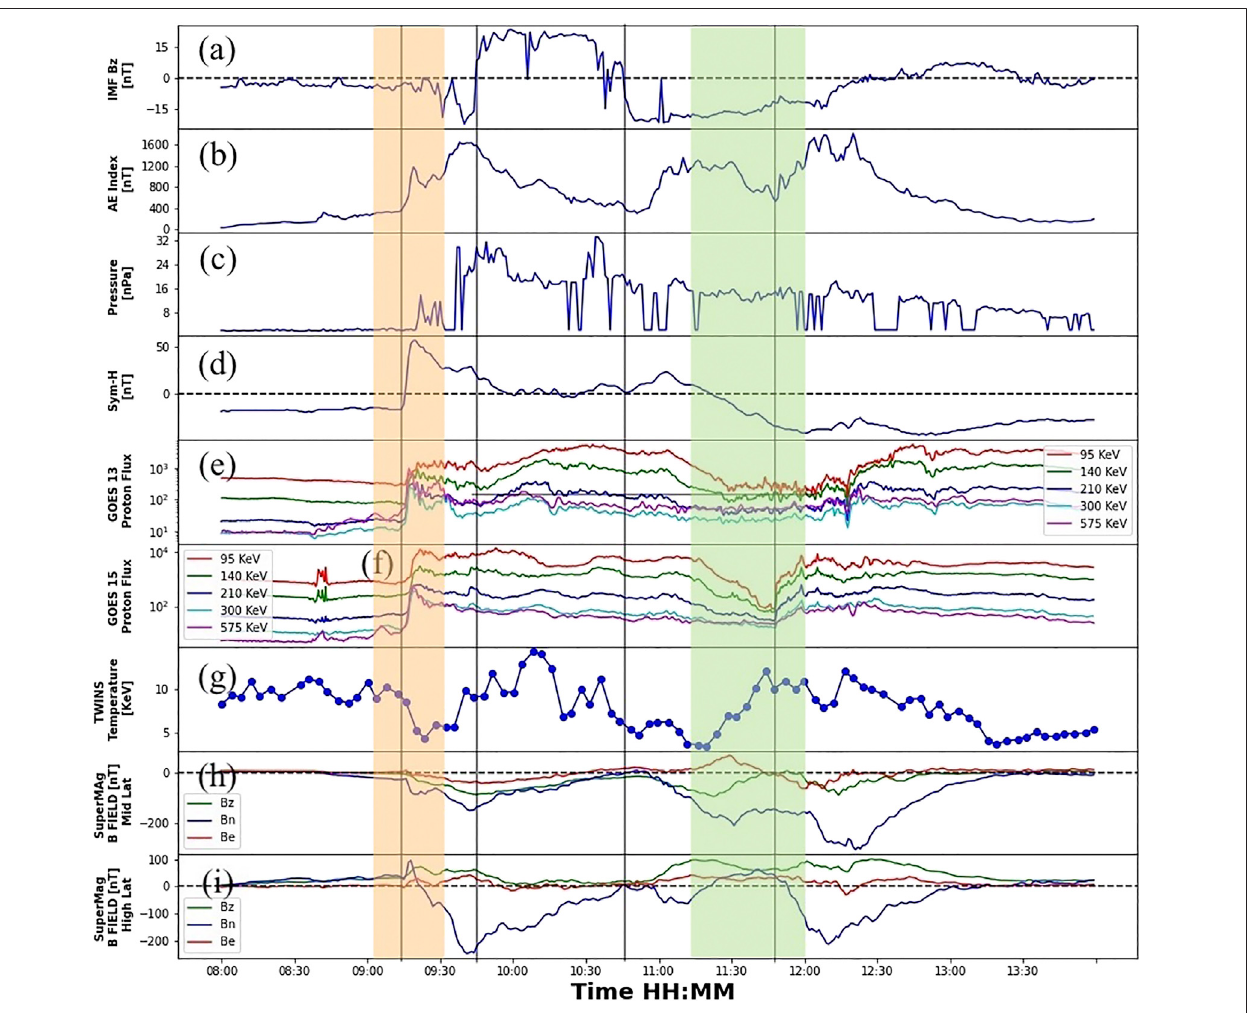
Figure 1 is calculated from these maps by selecting the area from 5 to 20 R E and magnetic local time (MLT) from 20:00 to 4:00. A movie of ion temperature maps for the entire storm interval is in the Supplementary Material . Regions of increased ion temperatures are observed prior to the SSC, likely due to the steady southward IMF Bz prior to the shock arrival driving tail reconnection and earthward fl ows (as evidenced by the AE index increasing to ∼ 400 nT in Figure 1B ). At the time of the SSC, the plasma sheet temperatures drop signi fi cantly across the entire fi eld of view, as seen in Figure 2D . Regions of increased ion temperature begin appearing again in the 9:22 – 9:26 UT interval ( Figure 2F ) with the most intense region occurring in the dusk half of the magnetotail. These regions appear localized across the magnetotail and elongated along the tail and move towards the inner magnetosphere,